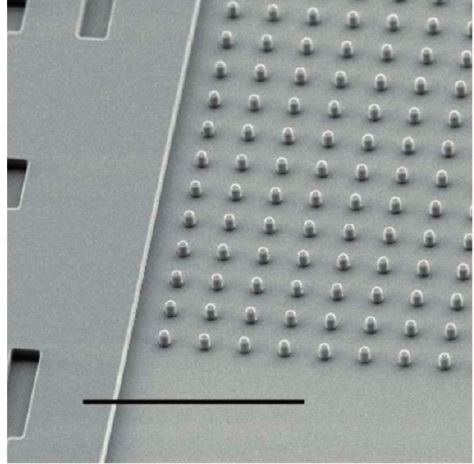
Figure 4. SEM image of Silicon pillars formed via plasma processing (scale bar = 20 μ m). Reprinted with permission from Elsevier, 2001